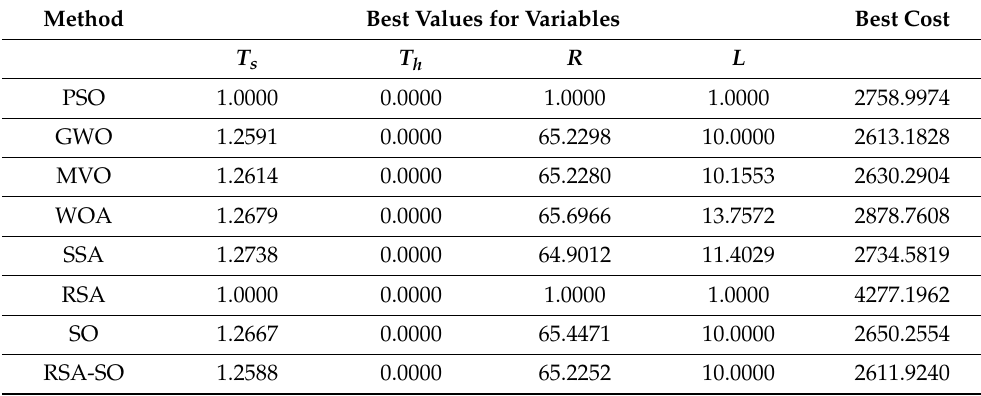
Table 7. Results of RSA-SO and other methods for solving the PVD problem. Method